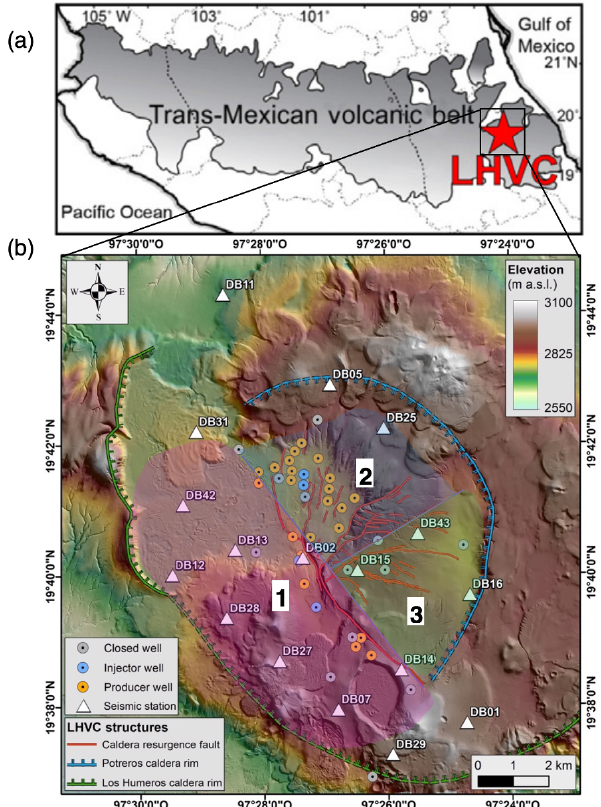
Figure 1. Modified from Norini and Groppelli (2020). (a) Trans- Mexican Volcanic Belt (TMVB), with location of LHVC (Negin and Akbarov, 2019). (b) Volcanotectonic map of the Los Potreros caldera area, being illuminated from the east (on a digital elevation model, DEM). The three key fault zones illuminated and sectioned off as follows: 1 – Maxtaloya–Los Humeros Fault Swarm; 2 – Ar- royo Grande Fault Swarm; 3 – Las Papas Fault and parallel